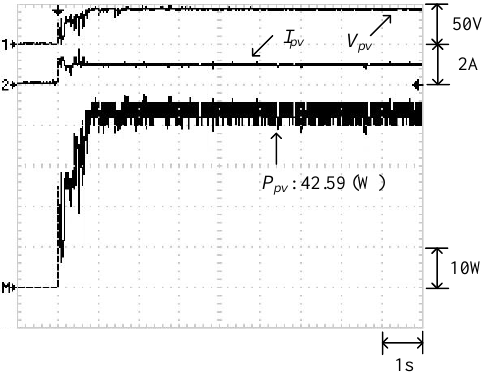
Figure 17. Maximum power point of Case 3 determined through the modified PSO algorithm.